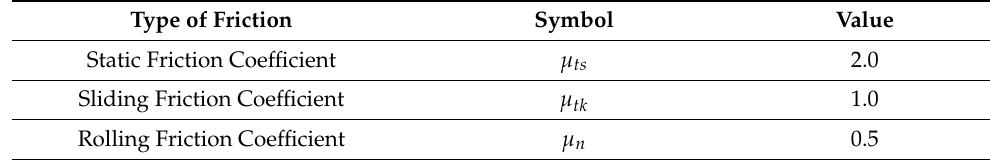
Figure 2. Profile of bed friction using anisotropic friction model. Table 1. Friction coefficients used in present